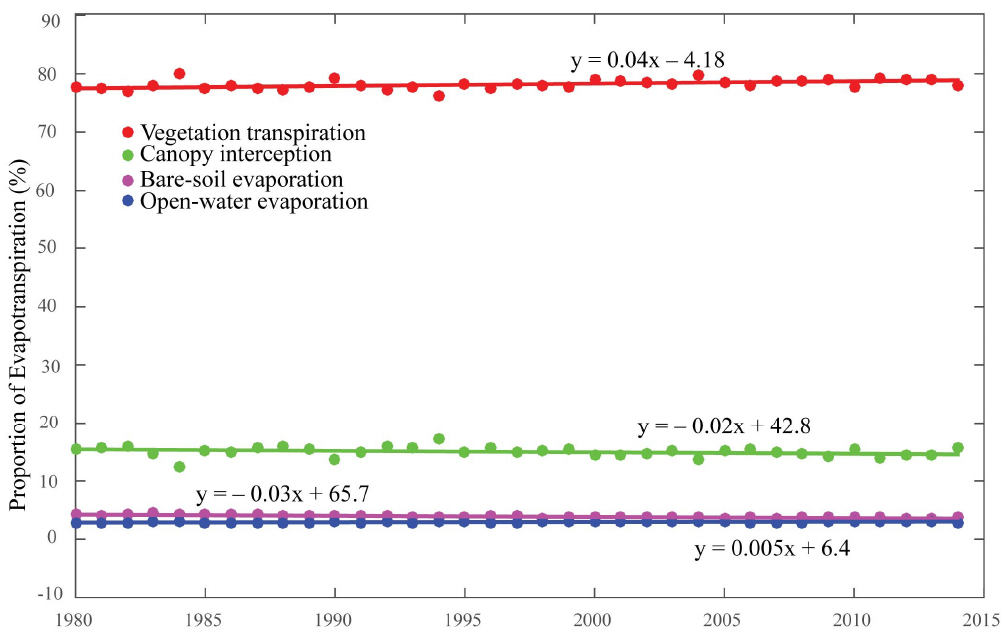
Figure 12. Monthly contribution proportions of different components to land ET averaged in the Nile Basin for 1980–2014.